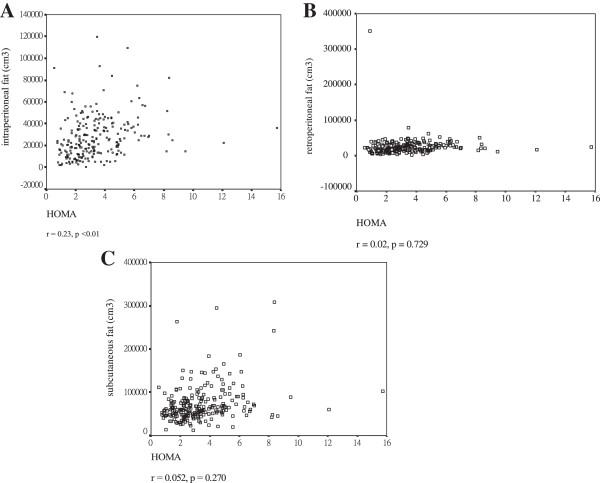
The relation between insulin resistance index calculated by HOMA and body fat distribution. A. Highly correlation between intra-peritoneal fat and insulin resistance. B. No significant correlation between retro-peritoneal fat and insulin resistance. C. No significant correlation between subcutaneous fat and insulin resistance.